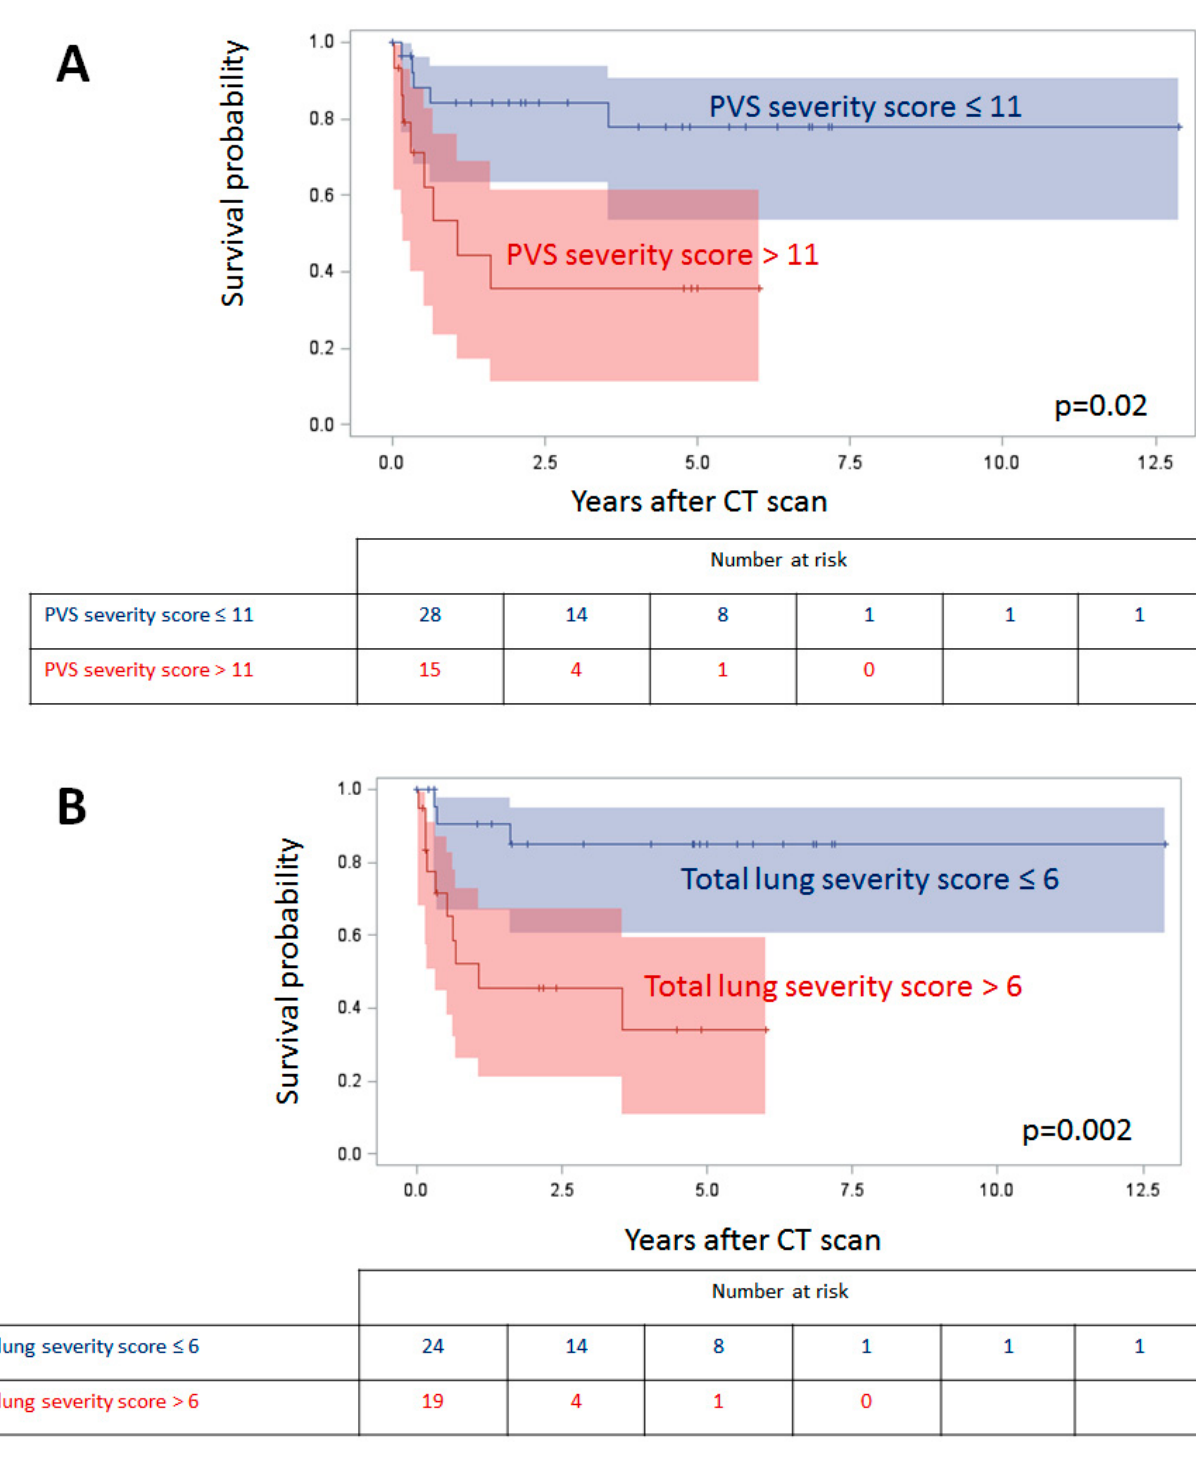
Figure 3. Survival by pulmonary vein stenosis (PVS) severity score ( A ) and total lung severity score ( B ) with 95% confidence intervals.